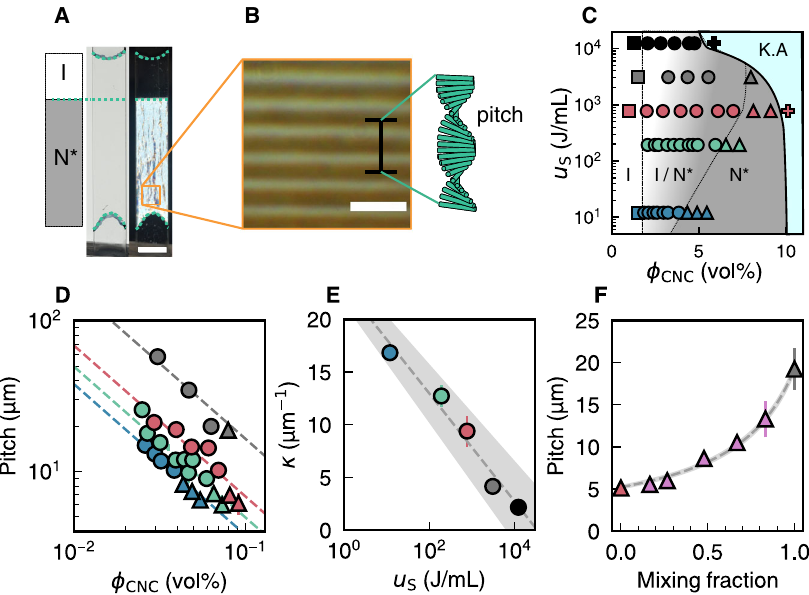
Fig. 3 Quantitative analysis of chiral self-assembly behaviour. A Macroscopic phase separation of a biphasic CNC suspension in a sealed rectangular glass capillary. Vertical separation into isotropic (I) and chiral nematic (N*) phases is evident when viewed under crossed polarisers (right photograph). Scale bar 5 mm. B Polarised optical microscopy of the N* phase from ( A ). The periodicity of the fi ngerprint pattern corresponds to a 180° rotation of the chiral nematic order and is equal to half the pitch. Scale bar 10 μ m. C Phase diagram versus CNC concentration and sonication dose, with the isotropic (I, squares), biphasic (I/N*, circles), chiral nematic (N*, triangles) and kinetically arrested (K.A., crosses) phases indicated. D Variation in pitch with CNC concentration for biphasic and chiral nematic suspensions (symbols match the phase diagram ( C )). Dotted lines indicate linear fi tting. E Decrease in chiral strength κ with sonication dose. Error bars indicate standard deviation of 30 measurements. Grey line indicates empirical logarithmic relation. Grey shaded region indicates uncertainty in fi tting. F Pitch of mixtures of ‘ low dose ’ (772 J/mL, red) and ‘ high dose ’ (3087 J/mL, brown) chiral nematic suspensions at equal CNC volume fraction. Error bars indicate standard deviation of 30 measurements. Grey line indicates fi tting to chiral dopant model. Grey shaded region indicates uncertainty in fi